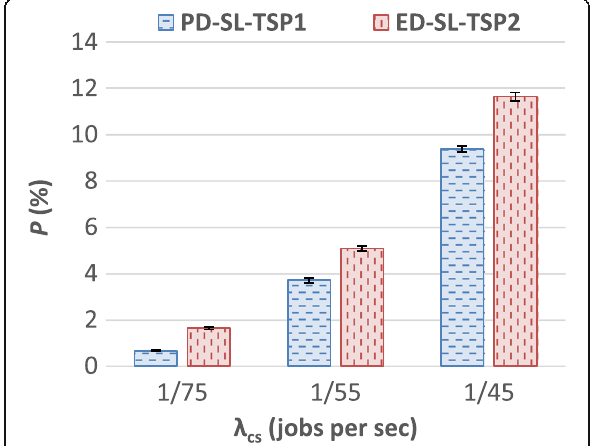
Fig. 14 Effect of λ cs on P when using the CyberShake workload with m = 20